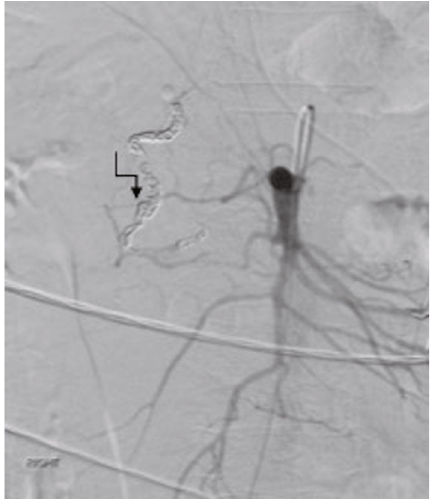
Figure 4: Postembolization angiography demonstrating complete stasis and sacri fi ce of arc of Buhler (zigzag